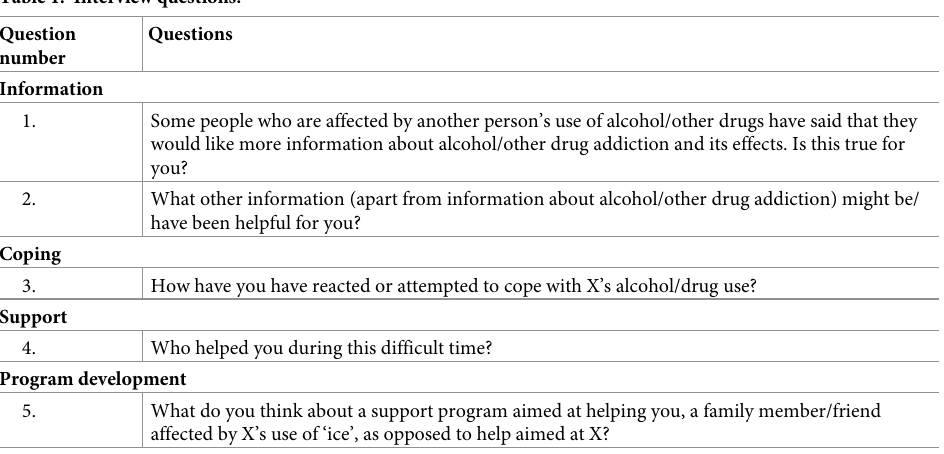
Table 1. Interview